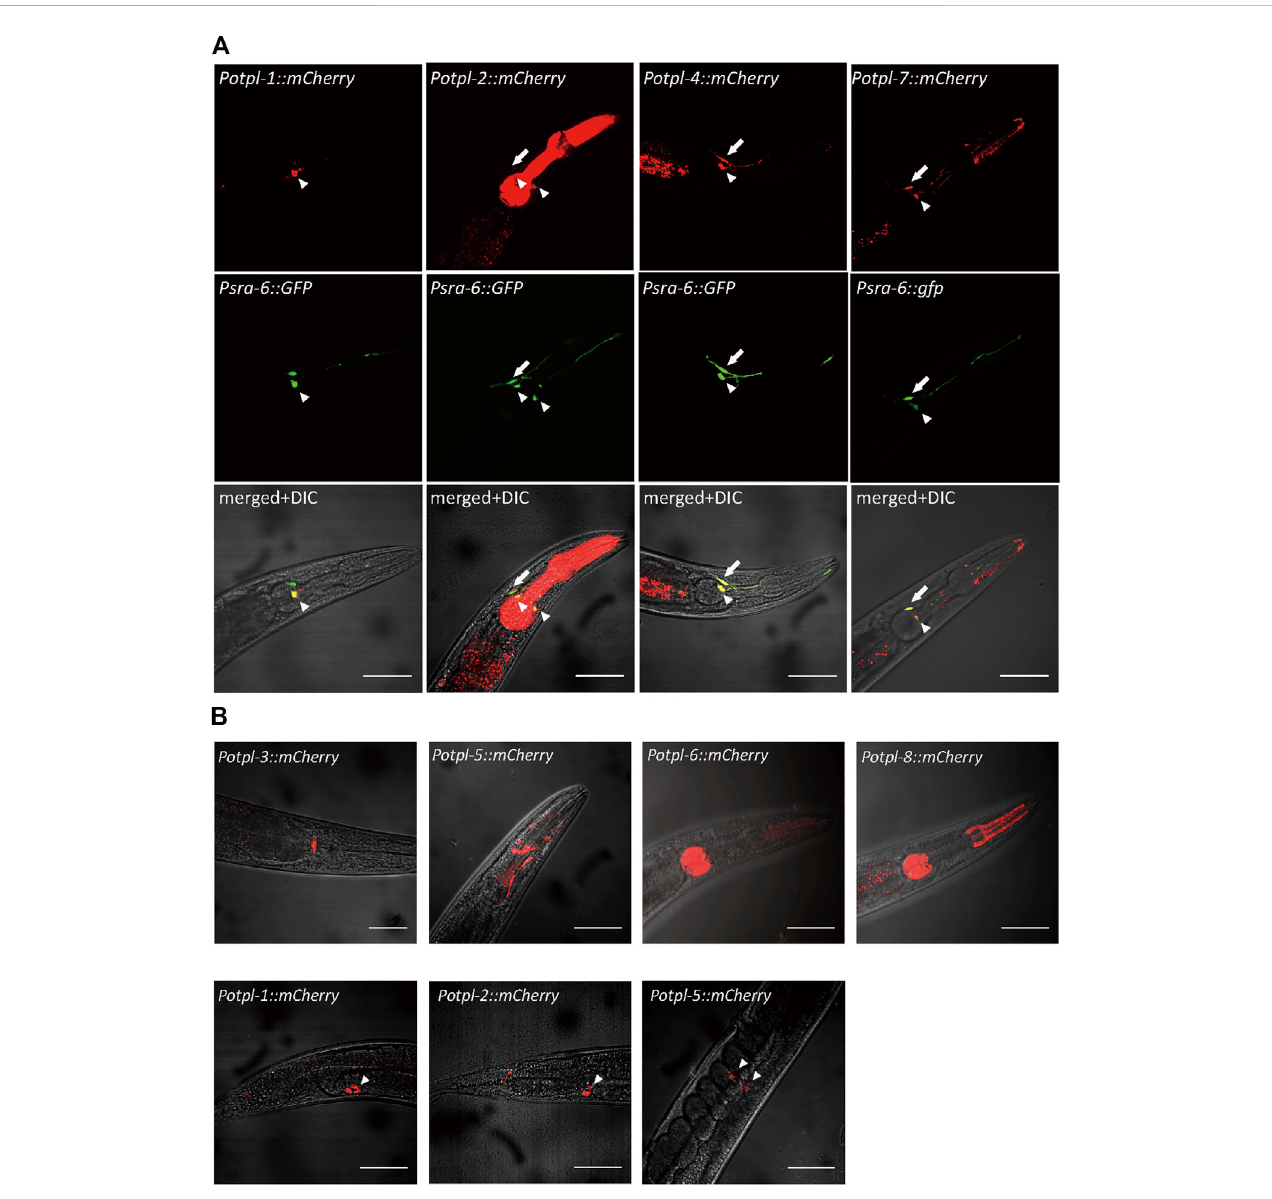
FIGURE 1 Expressionpatternsof C.elegansotopetrins . (A) Confocalimagesshowfour otopetrin geneco-locatedwithheadsensoryneuronsASHandASIneurons. Psra-6::GFP labeled ASH and ASI neurons with green fl uorescent proteins. Arrowheads indicate ASI neurons, and arrows indicate ASH neurons. Scale bar, 50 μ m. (B) The expression of otopetrin gene family in the nematode pharynx and head (upper) and in coelomocytes (lower). Scale bar, 50 μ m.